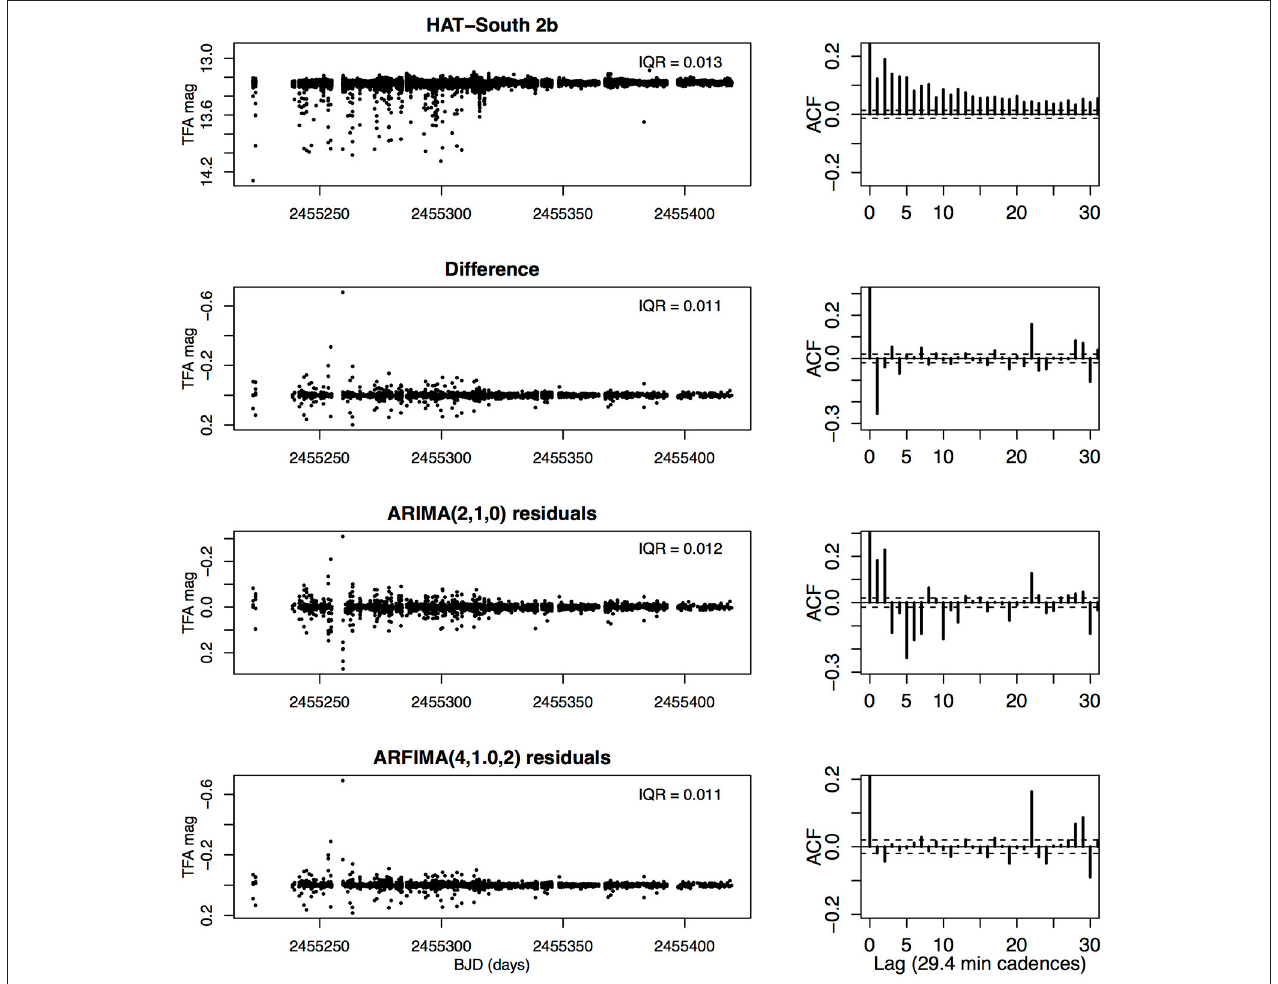
FIGURE 3 | Ground-based light curve for the planet-bearing star HATS-2b from the Hungarian Automated Telescope South network showing ∼ 6 months of brightness variations. Except for the top panels, the irregular observation times have been binned onto a fixed sequence of 29.4 min time bins.